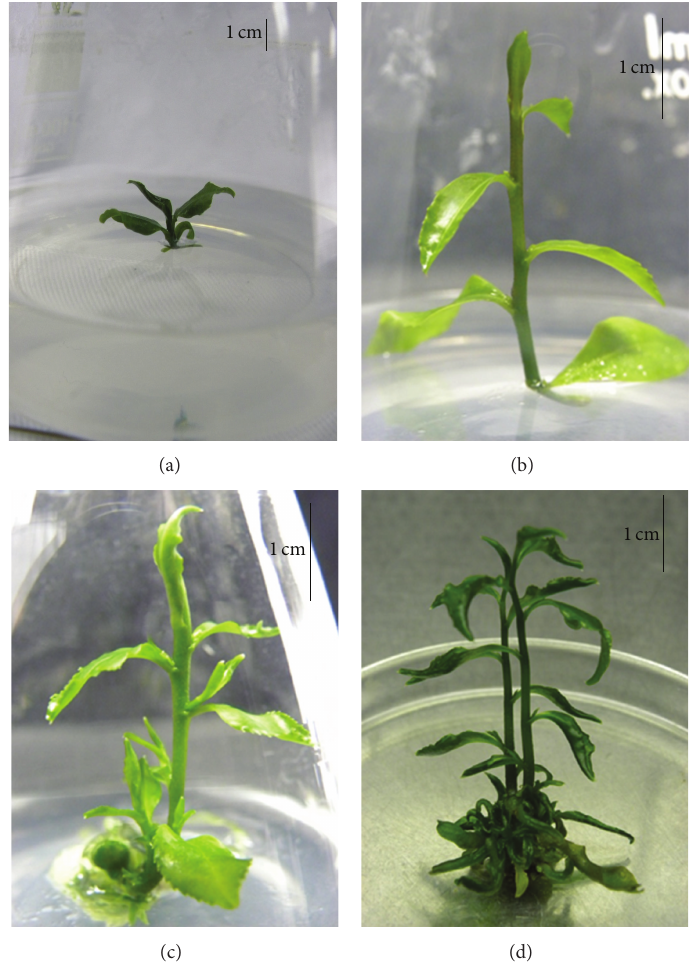
Figure 2: Effect of different concentrations of BAP (mg/L) in combination with GA 3 (mg/L) on shoot multiplication and shoot elongation, (a) BAP 0+ GA 3 0, showing no elongation; (b) BAP 0+ GA 3 0.5, showing elongation of single shoot; (c) BAP 1+ GA 3 0.5, showing multiplication and elongation of axillary buds; (d) BAP 3 + GA 3 0.5 mg/L, showing multiplication and elongation of more than one